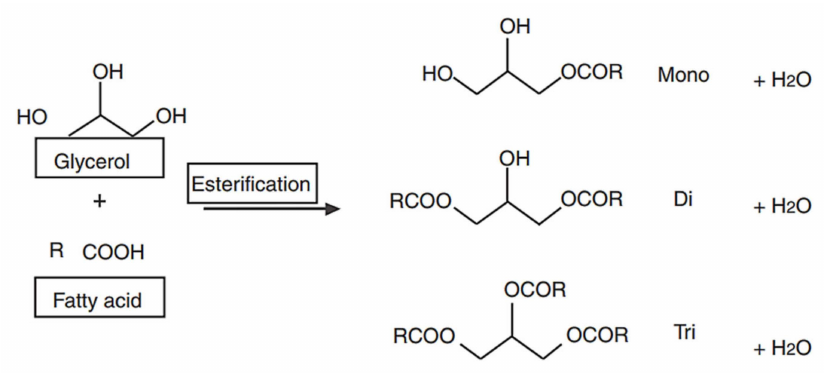
Figure 3. A schematic representation of the glycerolysis